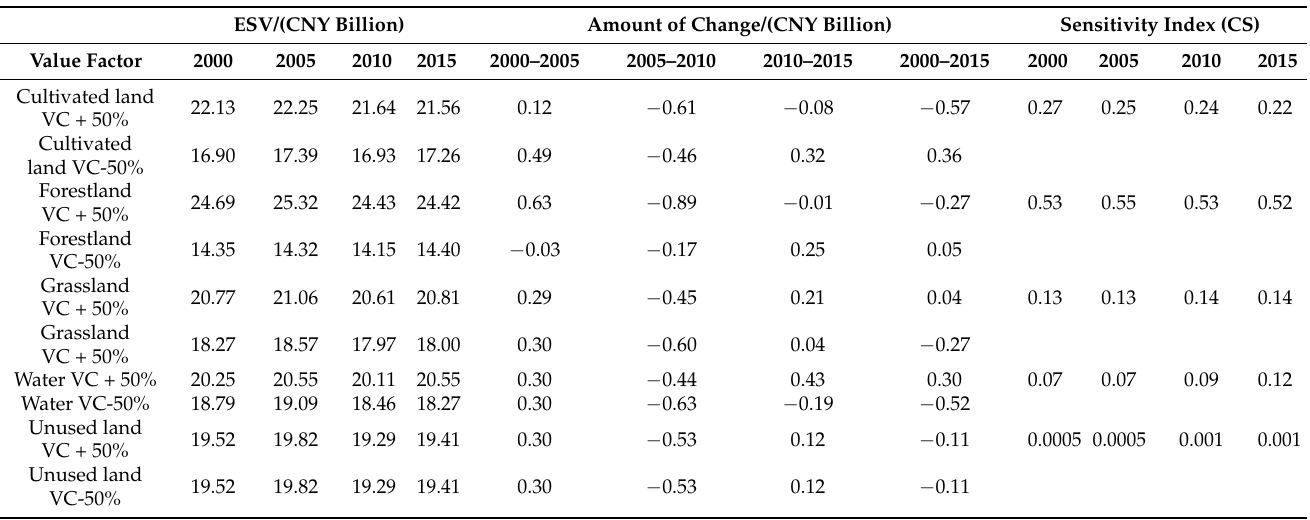
Table 5. Changes in the total value (CNY Billion), amount of change (CNY Billion) and sensitivity index of ecosystem services in Qihe watershed after